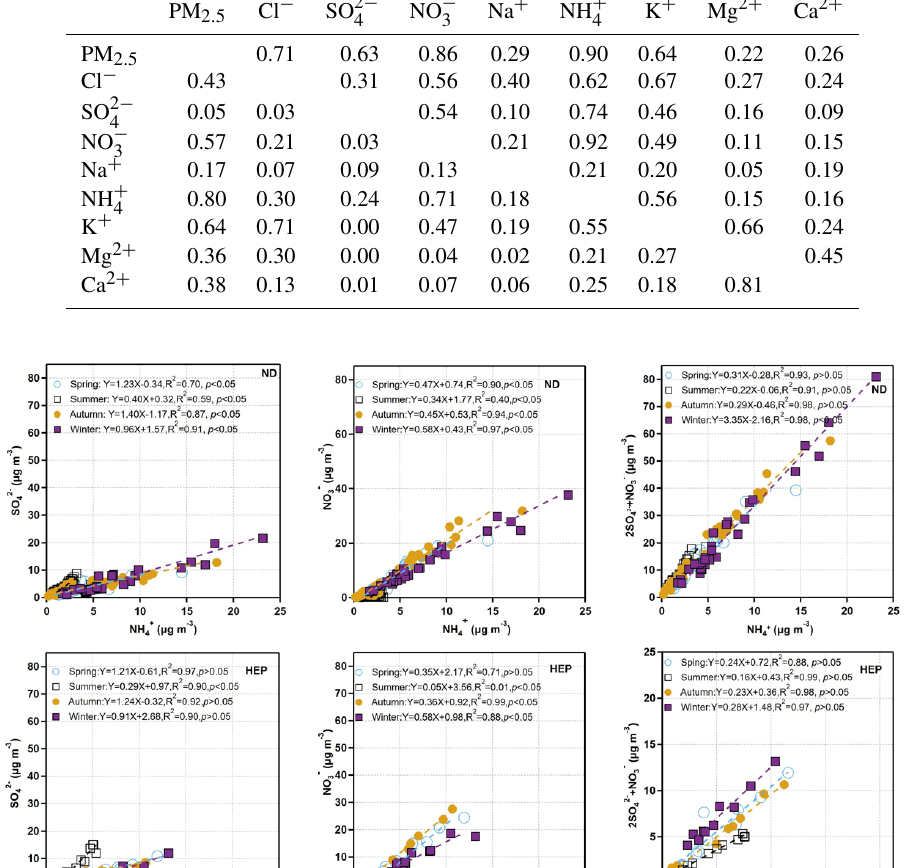
Table 3. Correlation coefficients ( R 2 ) of inorganic ions in PM 2 . 5 at ND (right) and HEP (left) in Tianjin, North China.